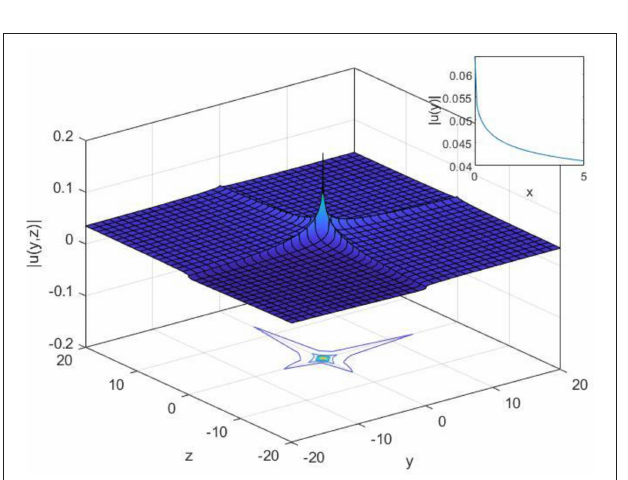
FIGURE 4 | 2-D, 3-D, and contour plot of singular soliton solution Equation (23) when λ a 0 0.1, b 0 =